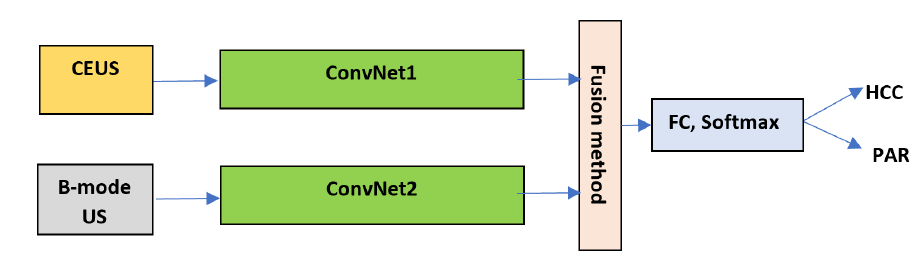
Figure 4. Classifier level fusion.